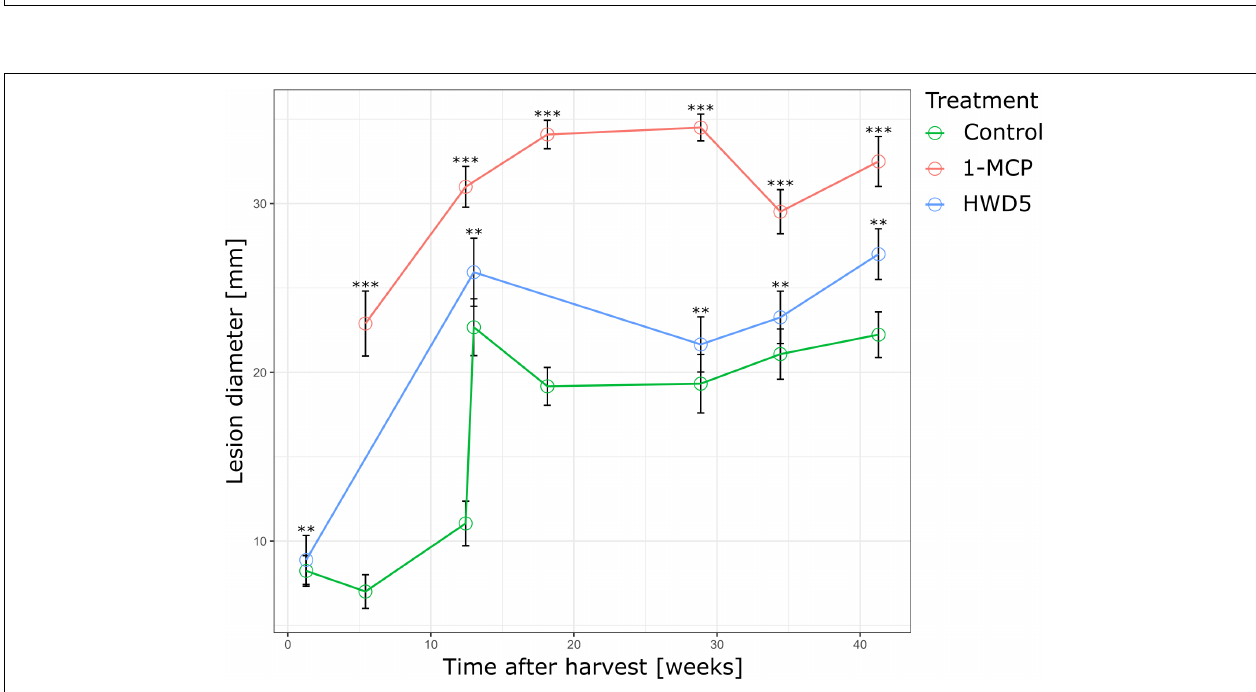
FIGURE 6 | Lesion diameter 96 hpi of pathogenicity assay performed at various time points throughout CA storage for control, HWD5 and 1-MCP treated apples inoculated with B. cinerea . Error bars denote the standard error of the mean ( n ≥ 10). Significant differences are indicated by an asterisk. ∗∗ p < 0.01 ∗∗∗ p < 0.001.